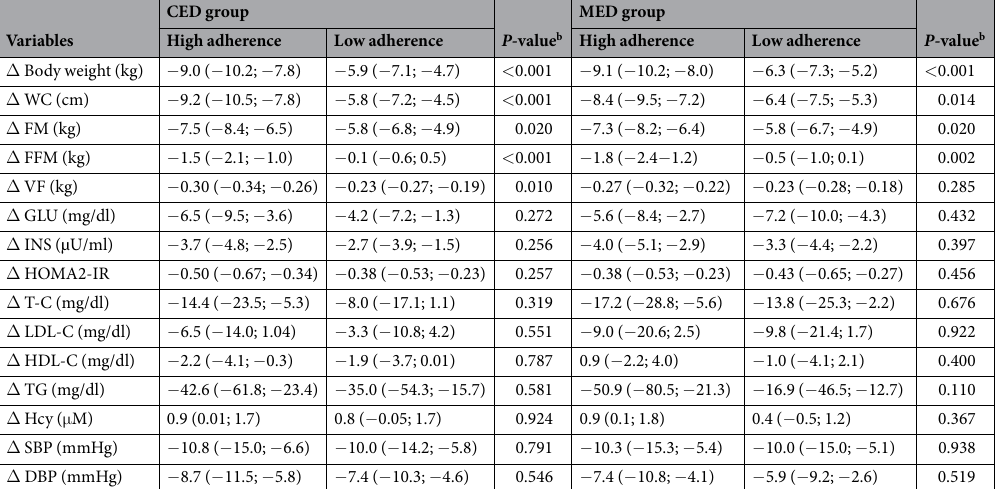
Table 6. Comparison of changes in selected parameters across median adherence in both diets a . Abbreviations: a Values are expressed as means (95% CI); BW: body weight; WC: waist circumferences; FM: fat mass; FFM: fat- free mass; VF: visceral fat; GLU: glucose; INS: insulin; HOMA2-IR: Homeostatic Model Assessment of Insulin Resistance; T-C: Total cholesterol; LDL-C: low-density lipoprotein cholesterol; HDL-C: high-density lipoprotein cholesterol; triglyceride: TG; Hcy: homocysteine; SBP: systolic blood pressure; DBP: diastolic blood pressure; b values for comparison of between-group (high vs. low adherence) changes (from baseline to follow-up). High adherence here means adherence scores above a median value, with low adherence referring to adherence scores below that median